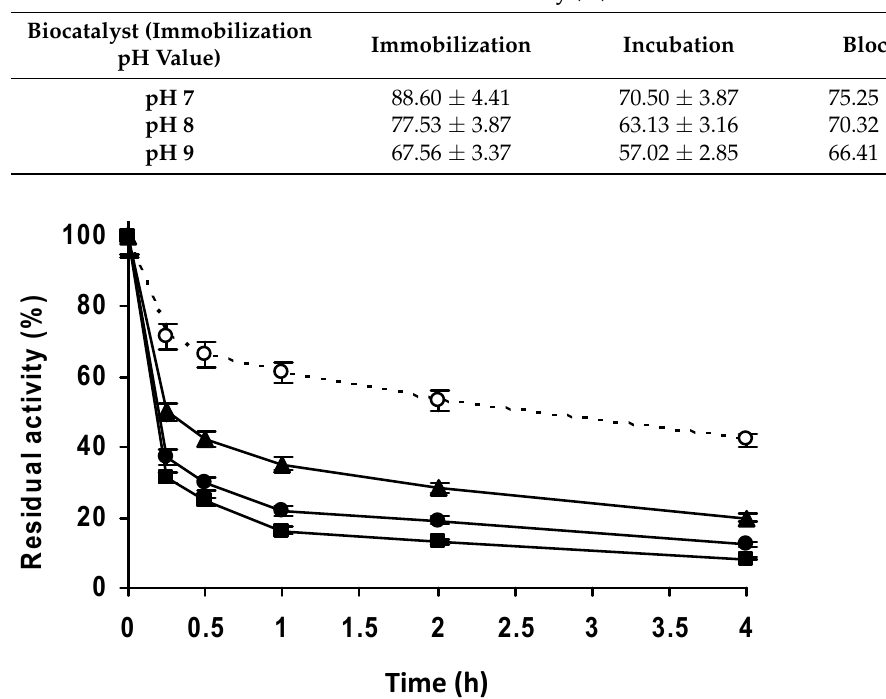
Figure 8. Thermal inactivation courses of PGA immobilized in VS-agarose at different pH values using 1 M sodium sulfate (see legend of Figure 7) compared to the enzyme immobilized in glyoxyl agarose. Empty circles with dashed line: glyoxyl agarose. Full triangles with solid line: immobilization on agarose-VS was performed at pH 7.0. Full squares with solid line: immobilization was performed at pH 8.0. Full circles with solid line: immobilization was performed at pH 9.0. Other specifications are described in the